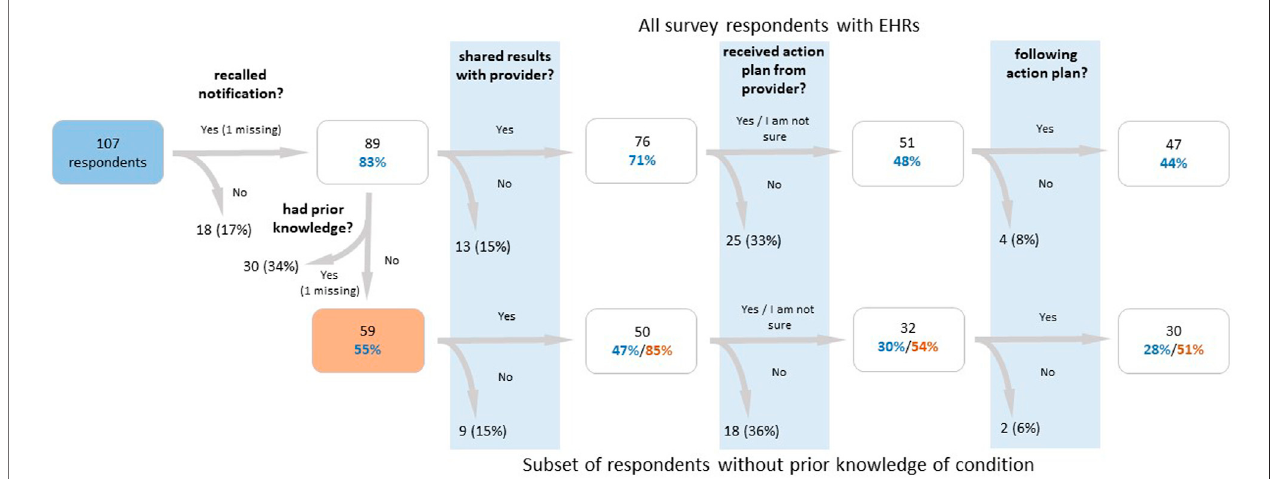
FIGURE 3 | Flow chart of participant survey responses for participants with a fi nding, who were noti fi ed of their fi nding, and who had an electronic health record. The lower branch of the fl ow chart examines participants who did not have prior knowledge of their fi ndings, while the upper branch examines all participants. Percentagesinbluetextarecalculatedoutofthetotalnumber ofrespondents,percentagesinredtextarecalculatedoutofthenumberofrespondentswhoreportedno priorknowledge(orwhoseresponsewasmissingforthatquestion),andpercentagesinblackarecalculatedoutofthenumberofrespondentsinthepreviousbox. From the left to right, the survey questions are as follows: (1) “ Did you receive positive genetic fi ndings from the Healthy Nevada Project? ” , (2) “ Were you aware of your genetic variant prior to participating in the Healthy Nevada Project? ” , (3) “ Have you shared your results with any of your healthcare providers? ” , (4) “ Did your provider design an action plan for you to follow? ” , (5) “ Are you currently following the action plan suggested by your provider? ”